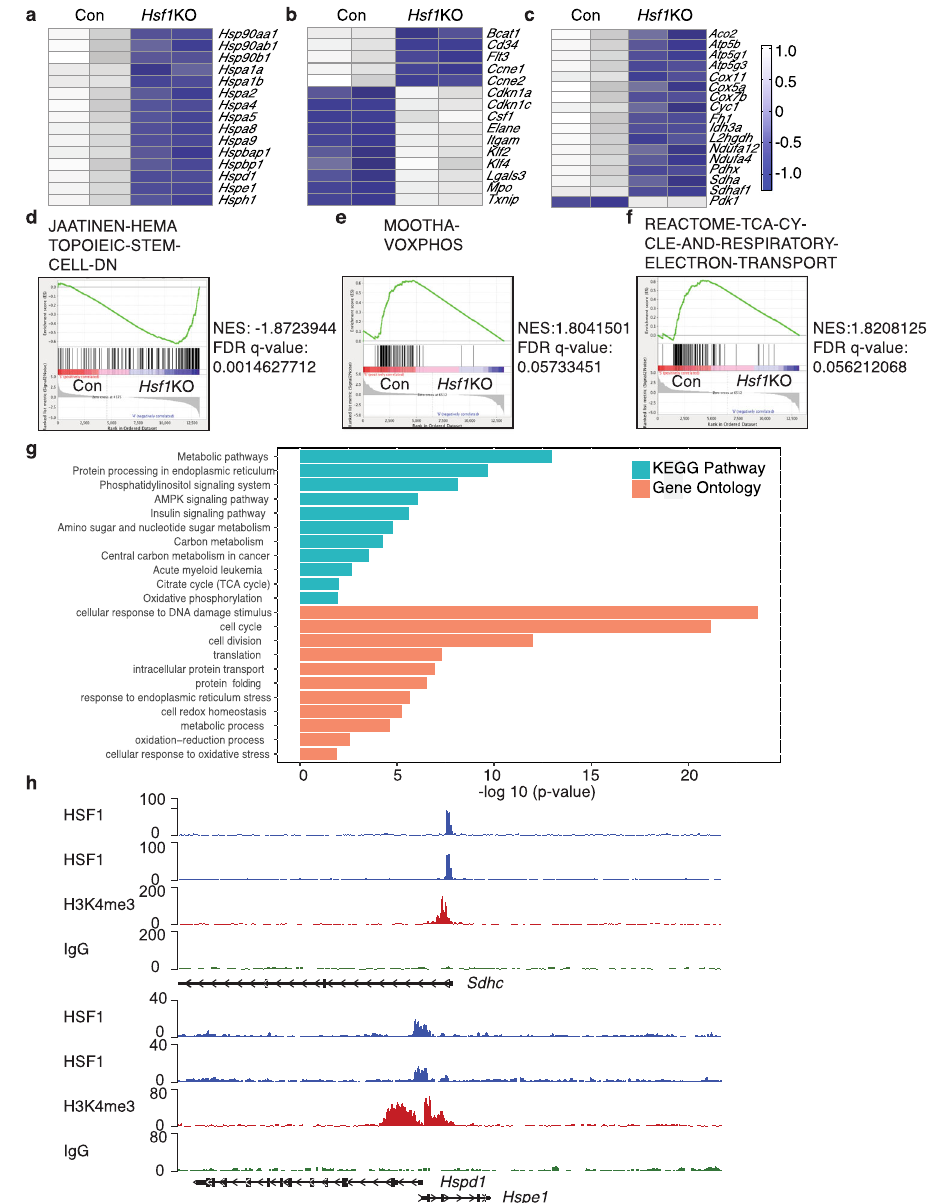
Fig. 4 | HSF1 regulated genes are involved in multifaceted LSC functions. a – c RNA-seq analysis of sorted Contol (Con) or Hsf1 KO MLL-AF9 LSCs (isolated from 2 full blown individual leukemia mice for each genotype). Hsf1 ablation ( a ) downregulateditsknowntargets — heatshockproteingenes;( b) upregulatedgenes relatedtomyeloiddifferentiation( Itgam , Elane , Mpo )anddownregulatedstemness related genes ( CD34 , Flt3 , Bcat1 ), and ( c ) genes related to OXPHOS. d – f GSEA revealed that Hsf1 deletionimpaired stem cellsignature( d ),down-regulated genes